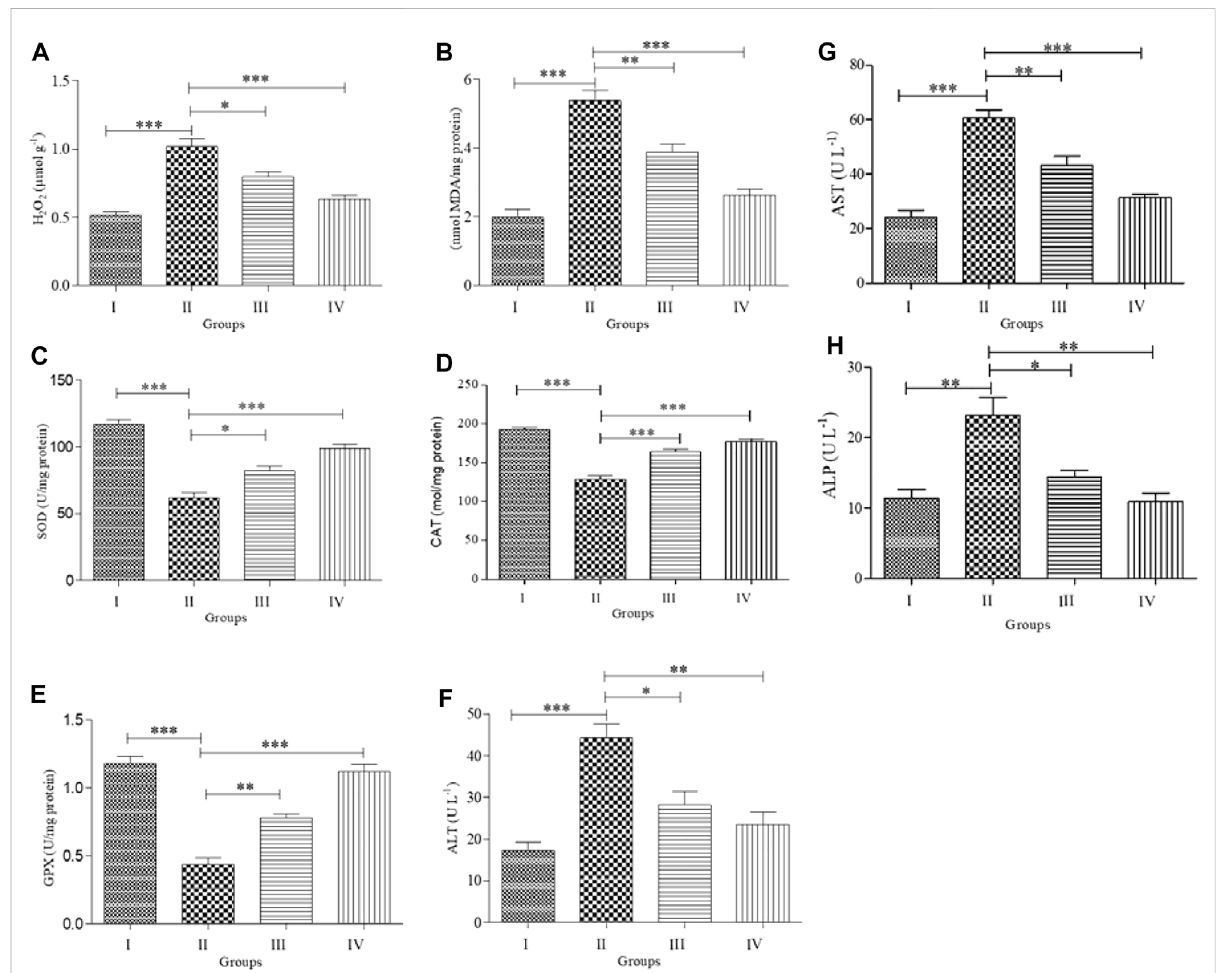
FIGURE 3 Effects of Abamectin (ABM; G II) and ZnNPs (G IV) alone and together (G III) on oxidative stress and antioxidant markers on serum blood of rats ( n